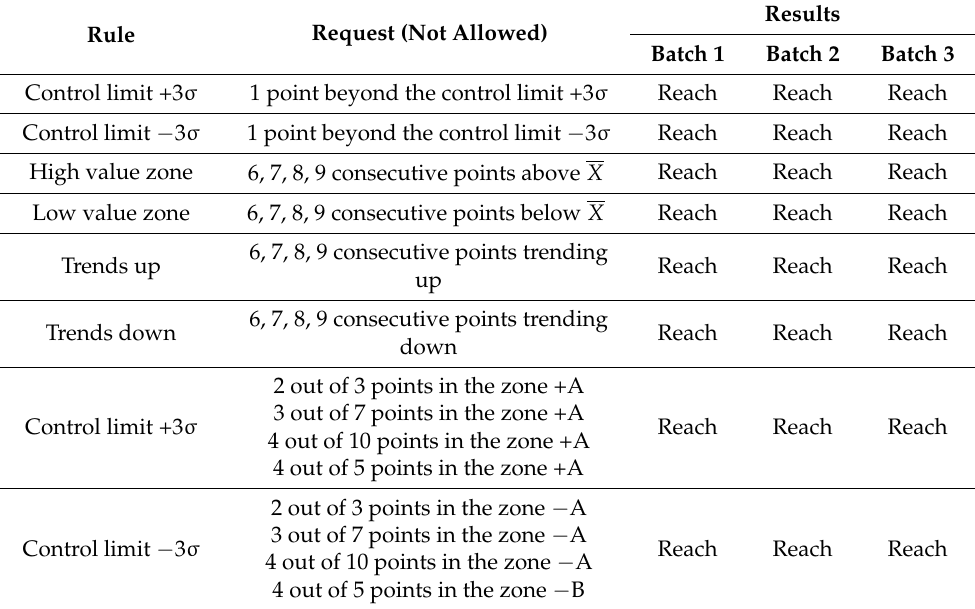
Results Batch 1 Batch 2 Batch 3